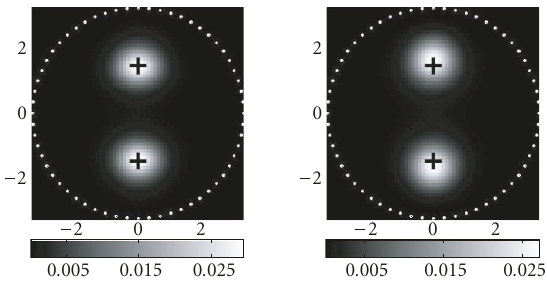
Figure 9: Comparison of the restoration results obtained with the spatially variant blur model (left) and with invariant one (right): phantom with two inhomogeneities of diameter 1 .